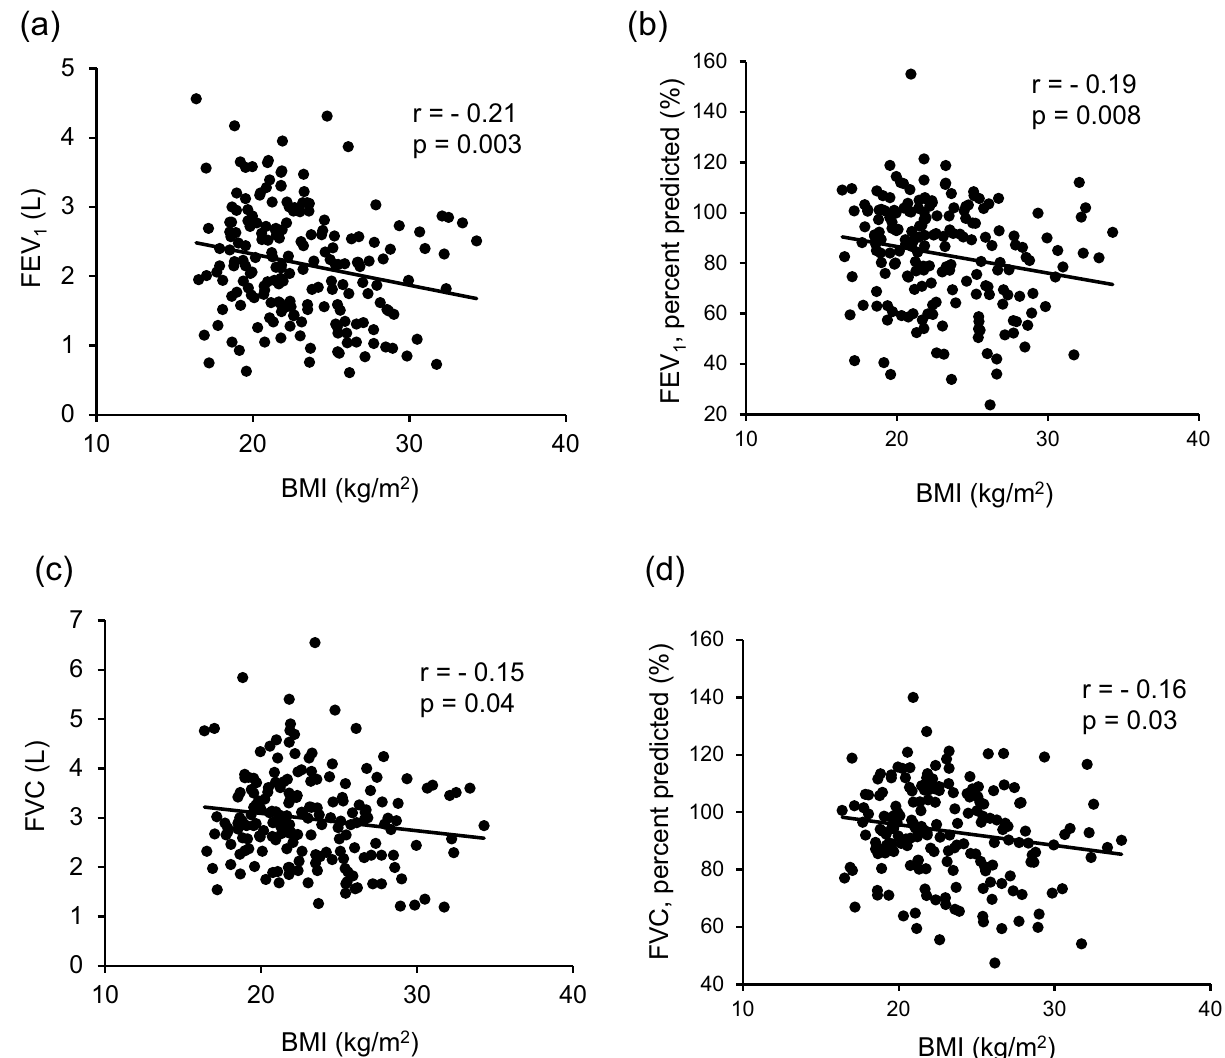
Figure 3. Correlations between forced expiratory volume in 1 s, forced vital capacity, and the body mass index in patients with asthma. ( a ) The forced expiratory volume in 1 s ( r = − 0.21, p = 0.003) and ( b ) the forced expiratory volume in 1 s, percent predicted ( r = − 0.19, p = 0.008) are significantly negatively correlated with the body mass index. ( c ) The forced viral capacity ( r = − 0.15, p = 0.04) and ( d ) the forced vital capacity, percent predicted ( r = − 0.16, p = 0.03) are correlated with the body mass index, though the correlation coefficient is